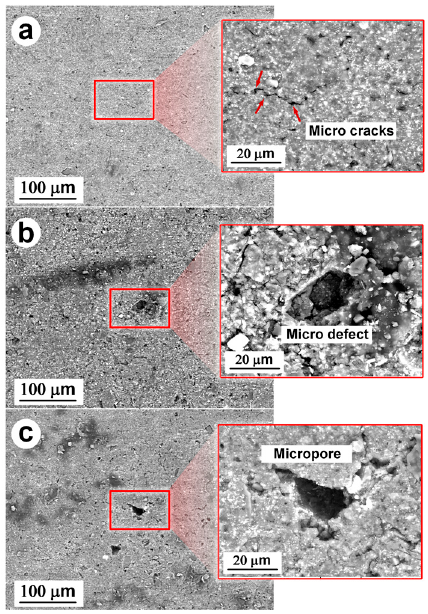
Figure 8. SEM micrographs of the surface of the intact area of the epoxy primer-coated specimens exposed for different durations: ( a ) 7 years, ( b ) 12 years, and ( c ) 20 years.